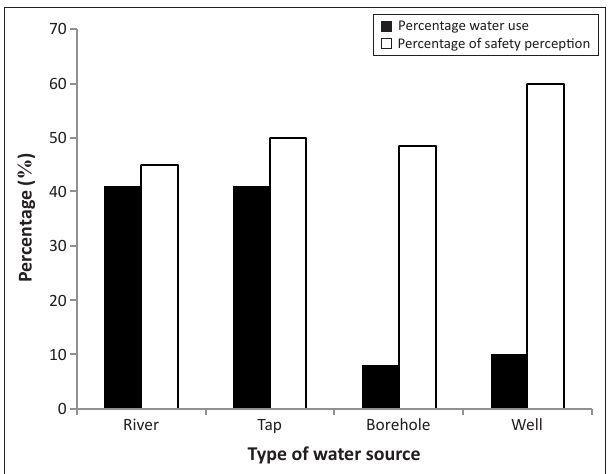
FIGURE 1 : The percentage use of water from different sources and their safety levels as perceived by various respondents.